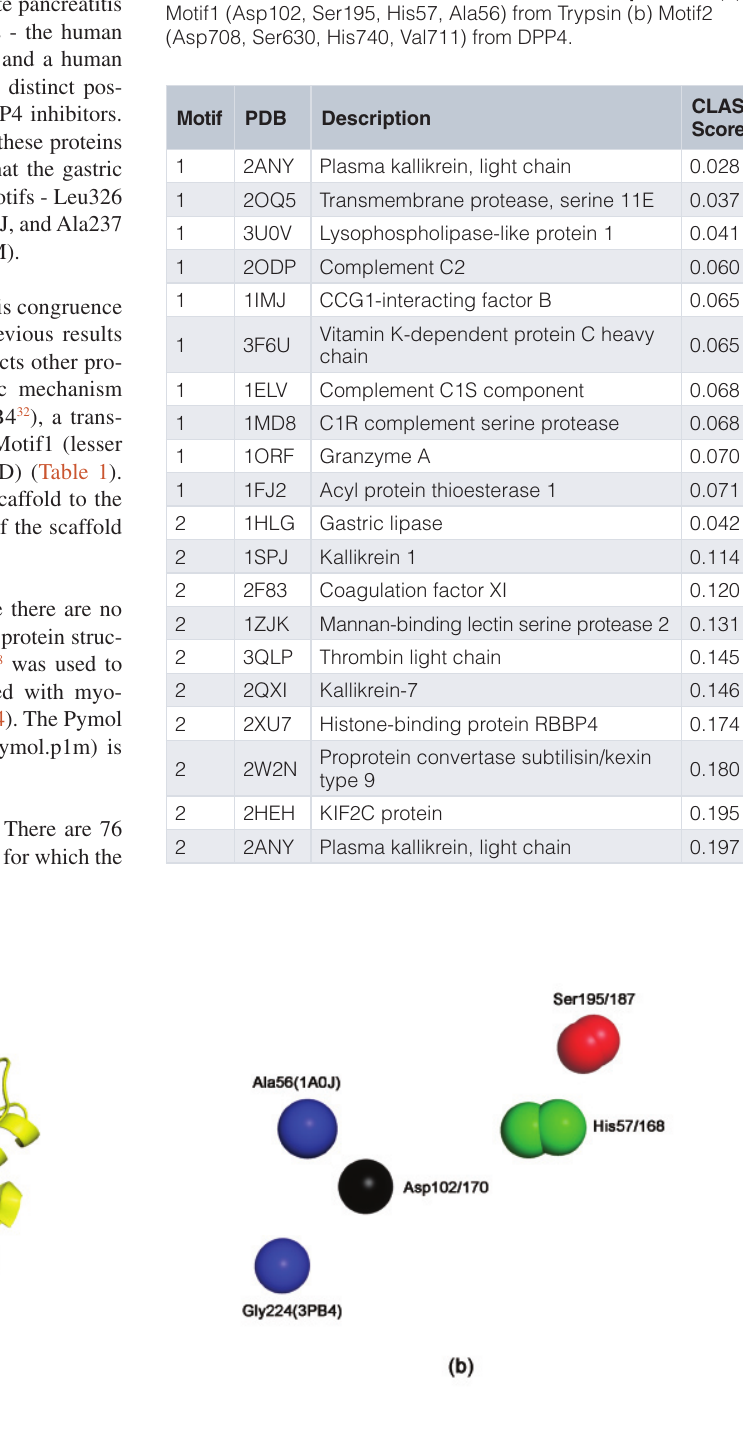
Figure 3. A scaffold congruent to the active site of Trypsin (PDBid:1A0J) in a glutaminyl cyclase (PDBid:3PB4). ( a ) The active site residues are marked in magenta. They are seen to be proximal to the identified scaffold. ( b ) Superimposition of Motif1 and the scaffold in glutaminyl cyclase. The exact pairwise interatomic distance and electrostatic potential differences are specified in Table